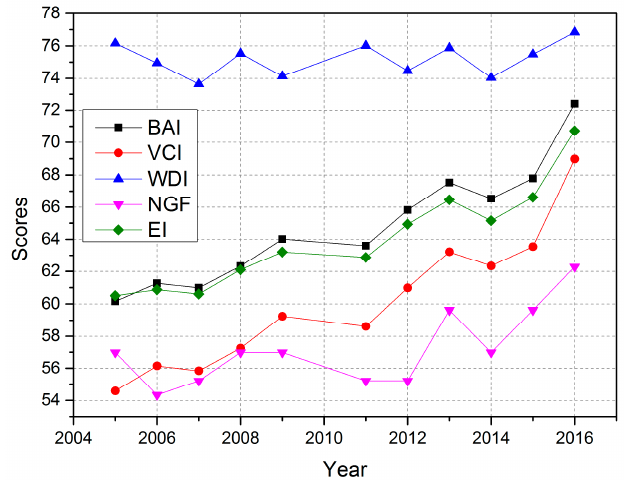
Figure 5. Scores of the EI and the sub-indices from 2005 to 2016. Table 8. The statistical results of the EI and the